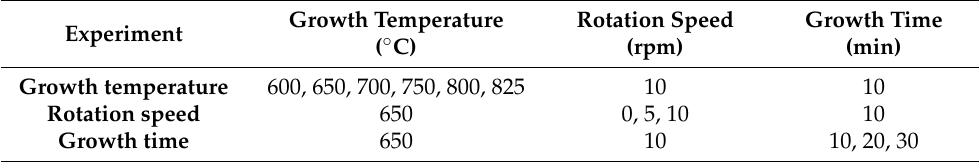
Table 1. Experimental variables investigated in this study.